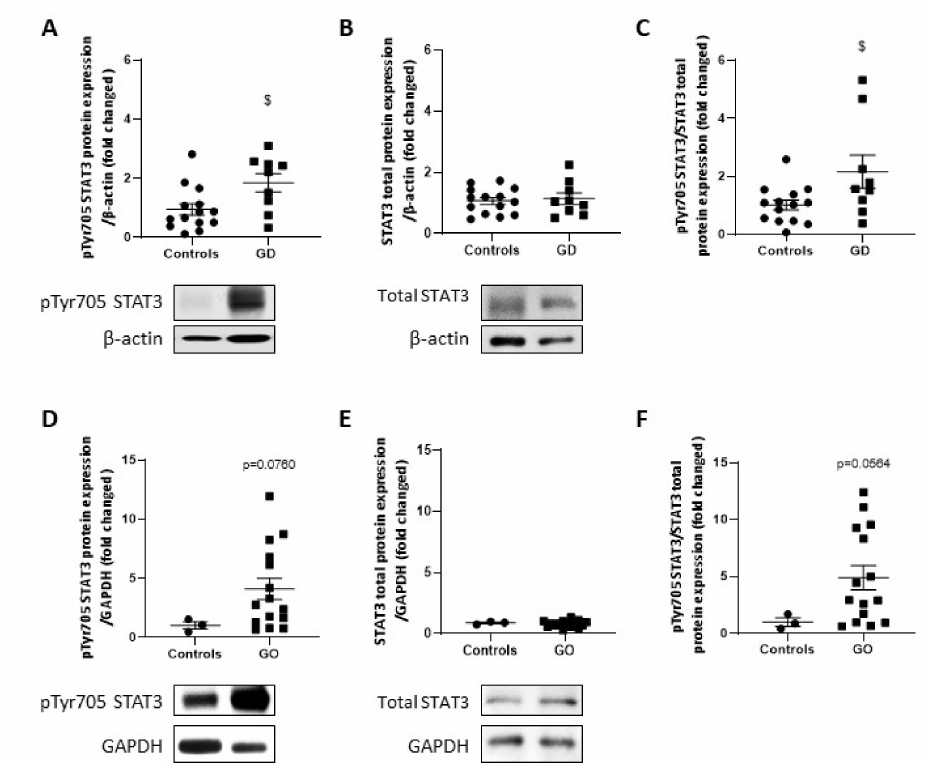
Figure 7. STAT3 is activated in GD thyroids and GO orbital fats. pTyr 705 STAT3 ( A , D ) and total STAT3 ( B , E ) were detected by Western blotting. Ratio of phosphorylated STAT3 to total STAT3 protein expression are represented in ( C , F ). A significant increase and an increasing trend of pTyr 705 STAT3 was observed in GD thyroids and GO orbital fats, respectively. Results are expressed as the mean ± SEM from 14 controls and 9 GD thyroids and 3 controls and from 15 GO orbital adipose tissues. $ p < 0.05 compared to controls. Densitometric values were normalized against β -actin for thyroid samples or GAPDH for adipose tissue. Western blots shown are representative of both